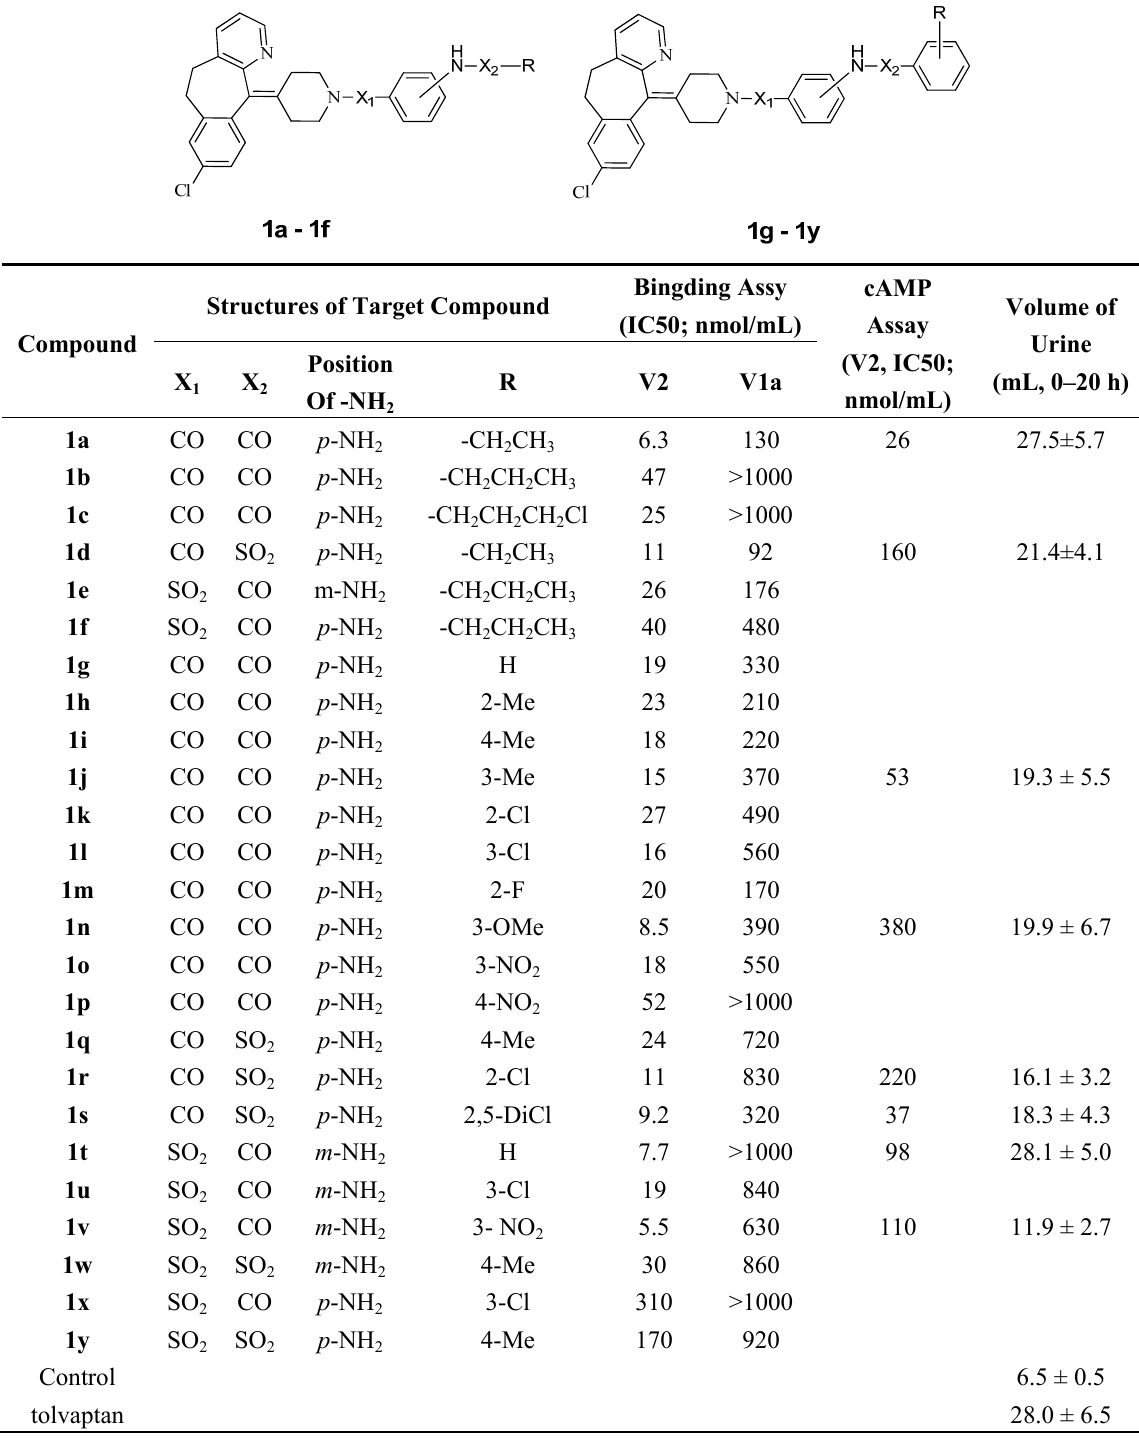
Table 1. The structures of the target compounds and their biological activity